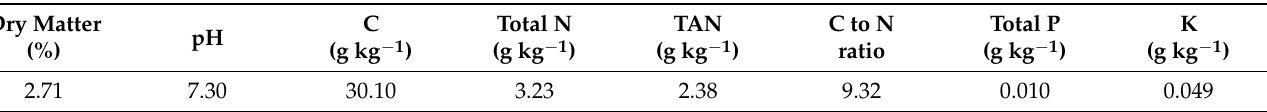
Table 3. Characteristics of the pig slurry (PS) used (mean of evaluations from 2012 to 2019); data expressed on a wet basis). Ibirub á , RS,